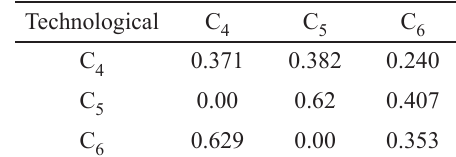
Table 6. The relative importance weights for criteria under the Demographic Group